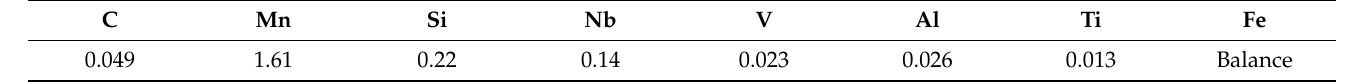
Table 1. The chemical analysis of tested steel samples